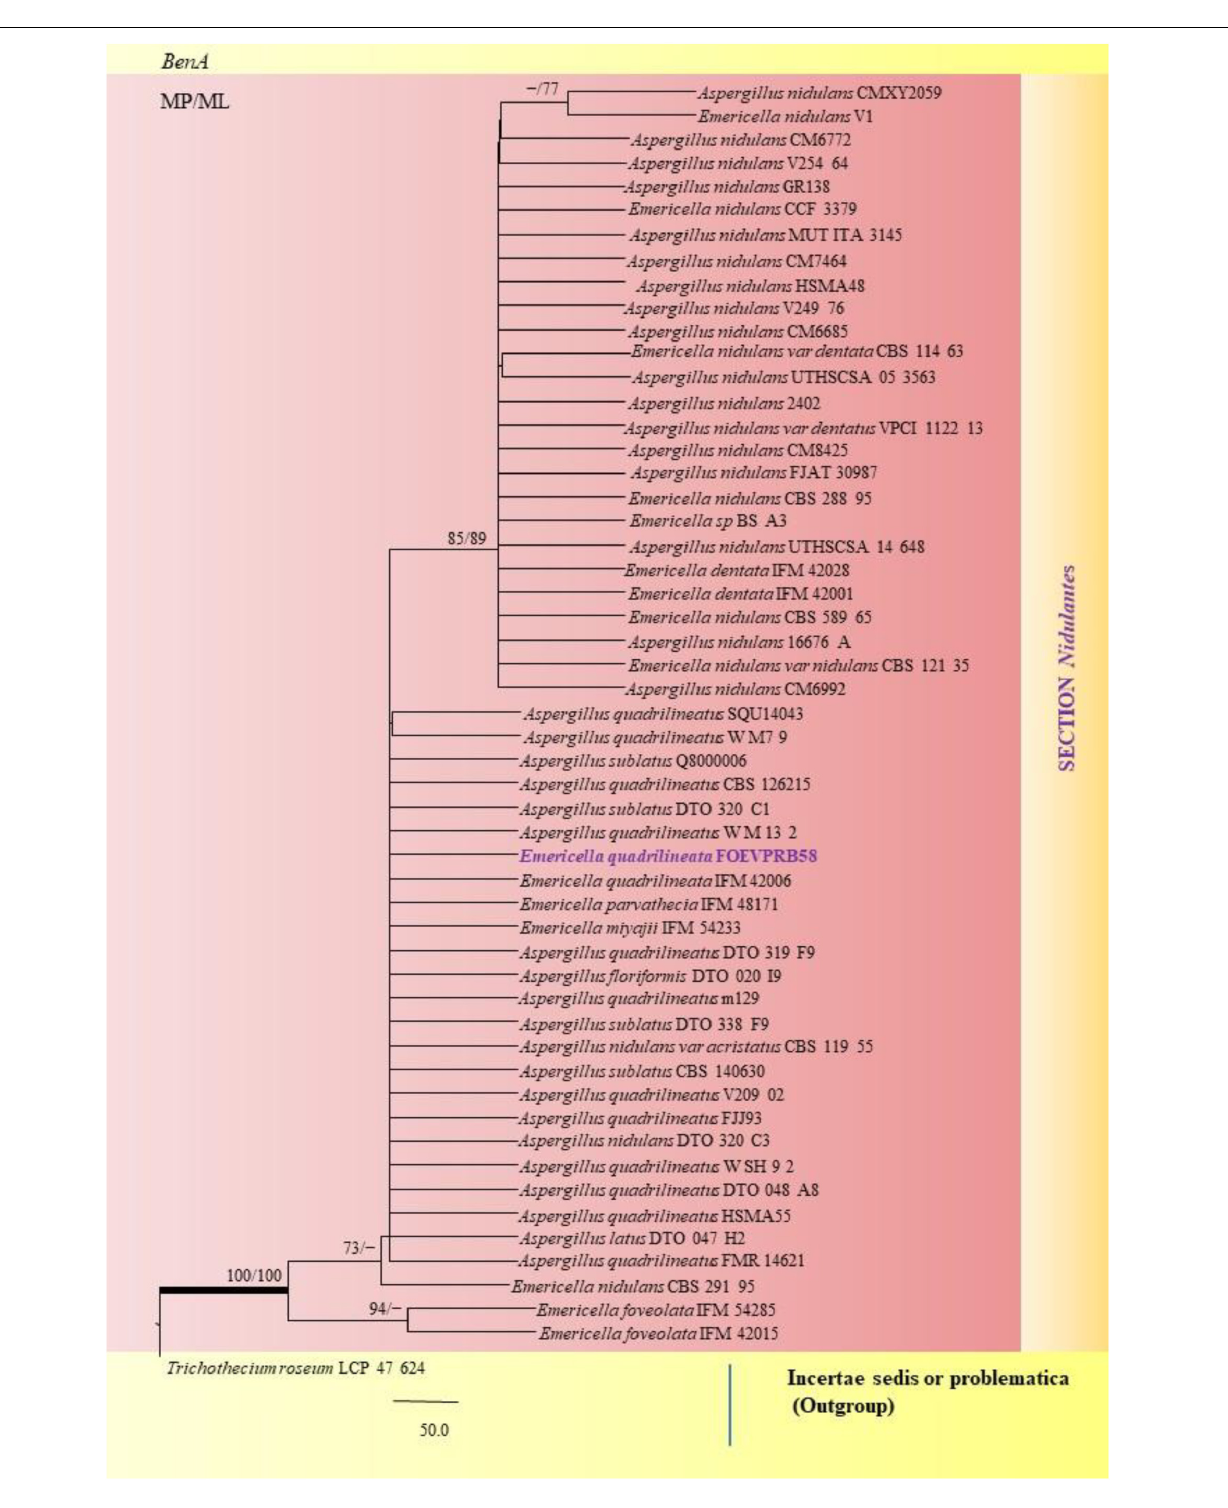
FIGURE 8 | A phylogenetic tree (taxon branching diagram) which presents the genetic analysis of the Emericella quadrilineata FOEVPRB58 clade belonging to the Section Nidulantes, exhibiting a maximum parsimony analysis of partial β -tubulin concatenated sequences, acquired. Bootstrap (bs) values ≥ 70% are designated at the nodes for maximum parsimony (MP) and maximum likelihood (ML) methods; branches with values ≥ 95% bs are bold black. A specific isolate code was mentioned as a suffix to the species name. Hyphen (-) represents the range of support values for parsimony and RAxML analyses of below 70%. Our isolate, which is marked in purple, was rooted using Trichothecium roseum LCP 47